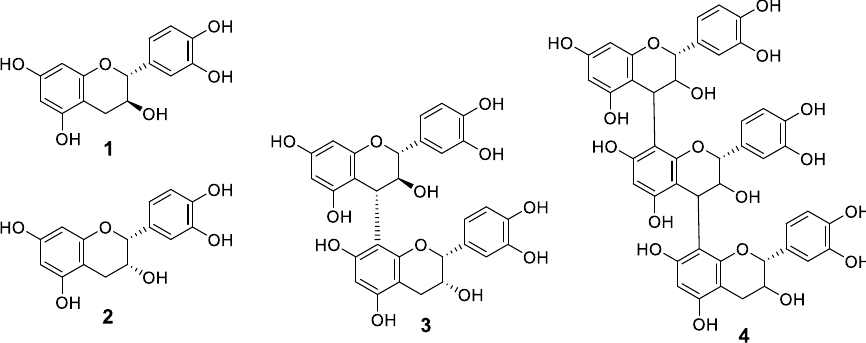
Figure 1. The structures of flavan-3-ol derivatives contained in raspberry.